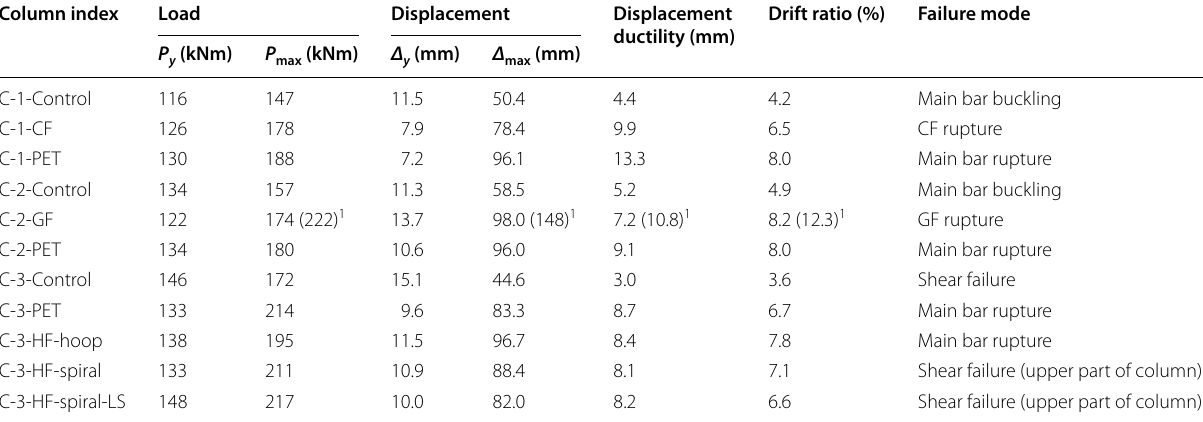
Table 4 Summary of column test results